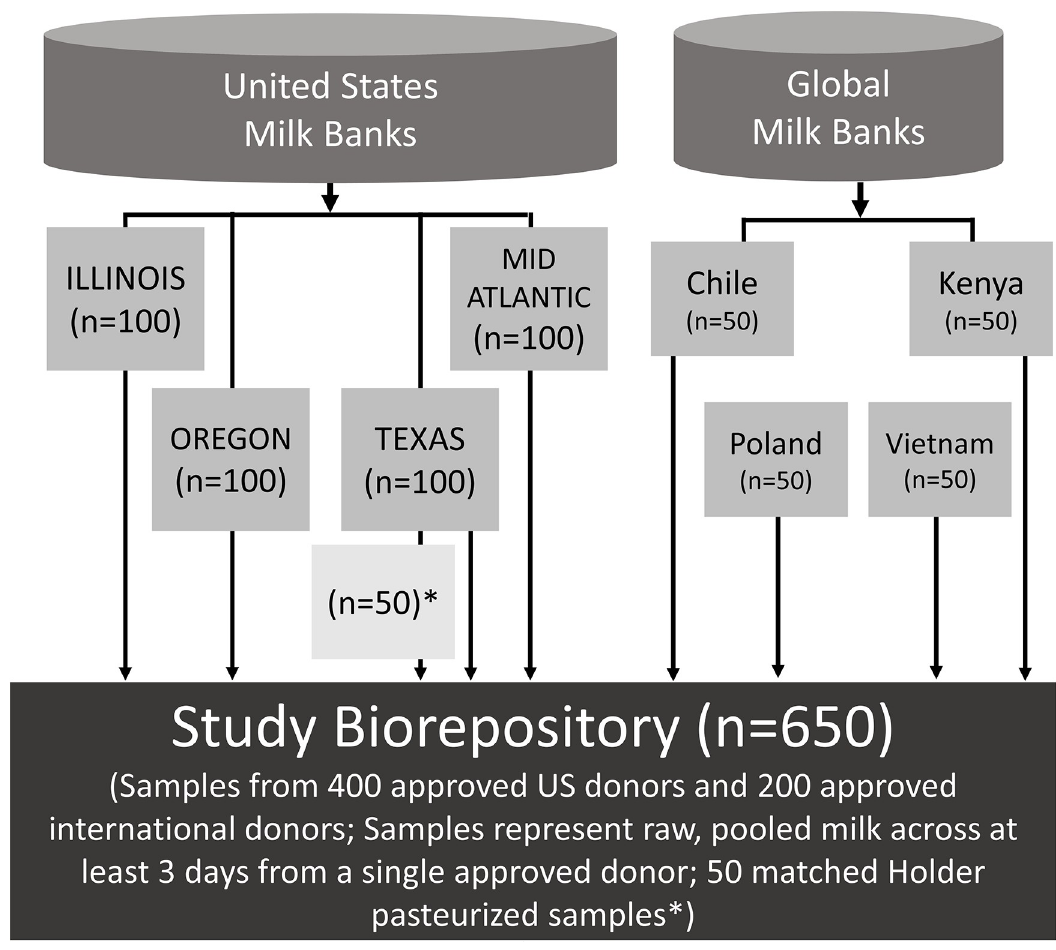
Fig 1. Overview of the global donor human milk